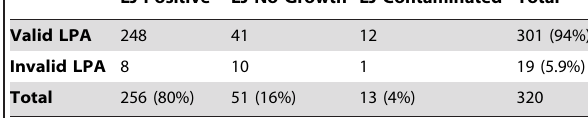
Table 1. Proportion of invalid LPA results in comparison to culture